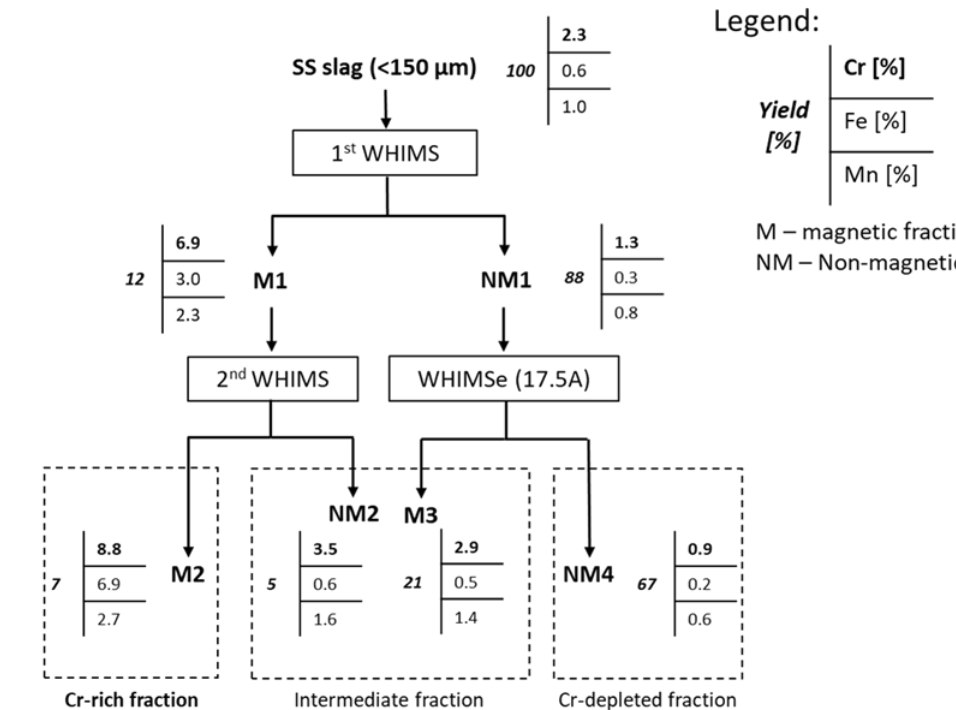
Figure 2. Processing of SS slag by combination of WHIMS and WHIMSe.